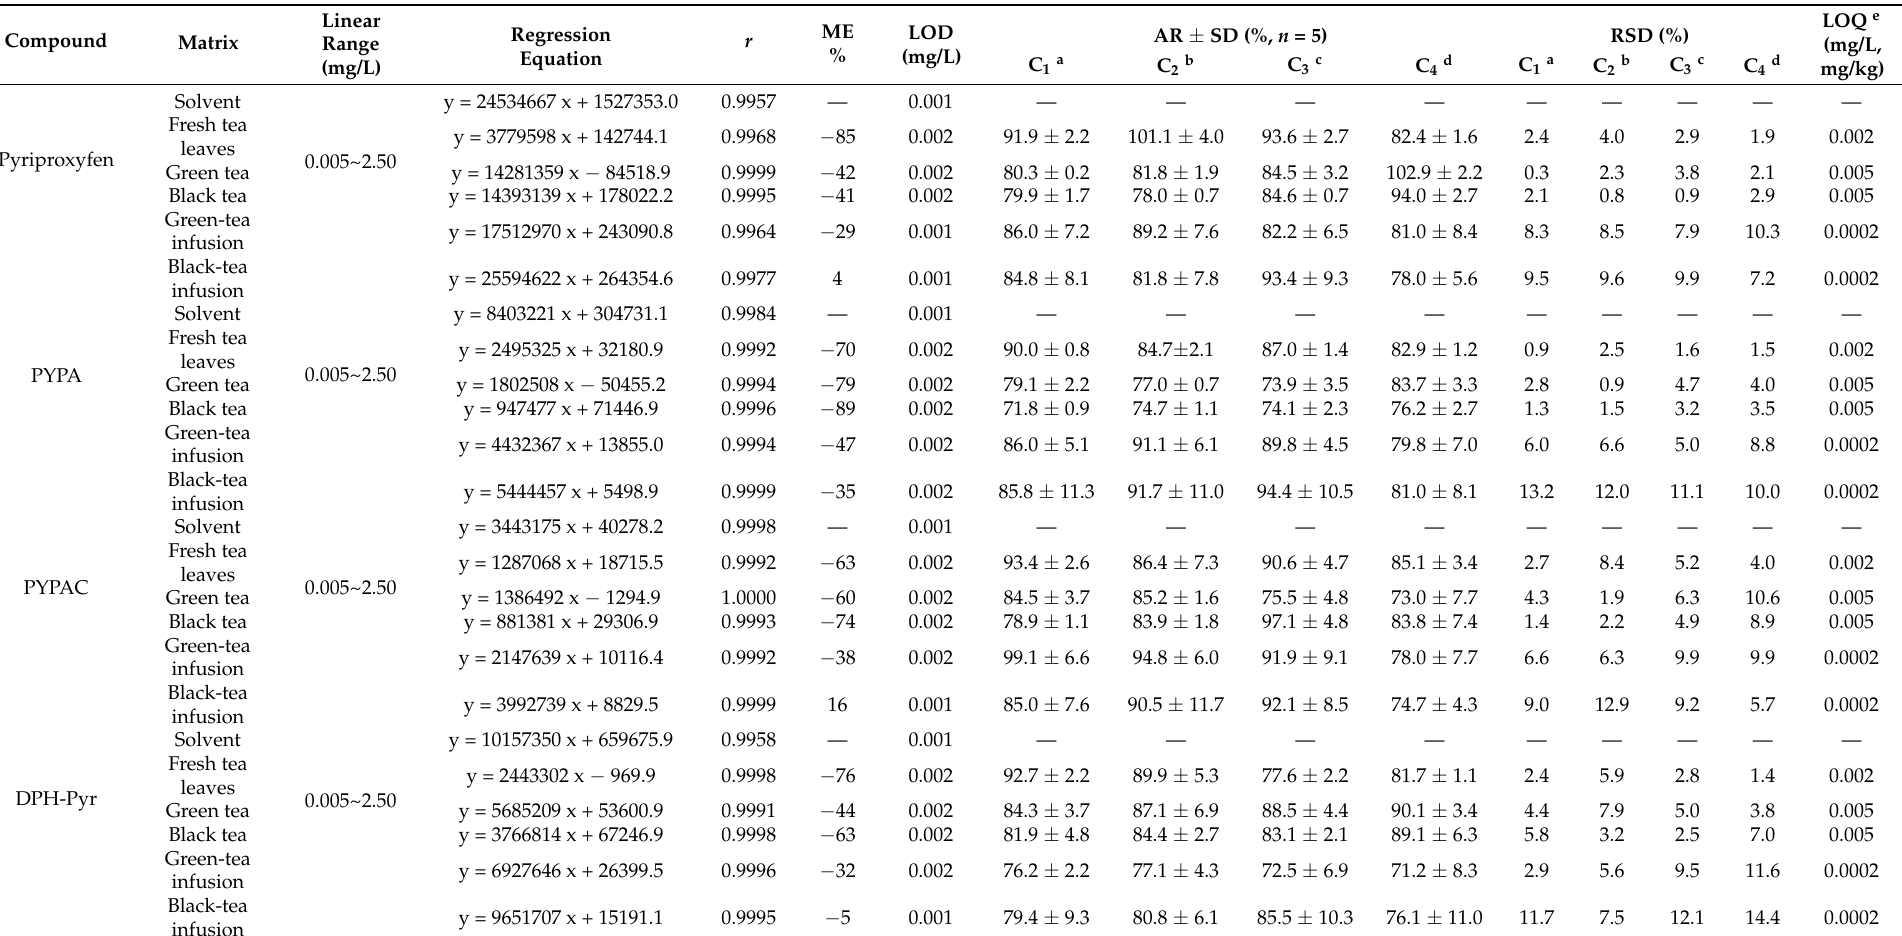
Table 2. Linear equations, correlation coefficients ( r ), matrix effects (MEs), limits of detection (LODs), average recoveries (ARs), standard deviations (SDs), relative standard deviations (RSDs) and limits of quantification (LOQs) of pyriproxyfen and its metabolites in different tea